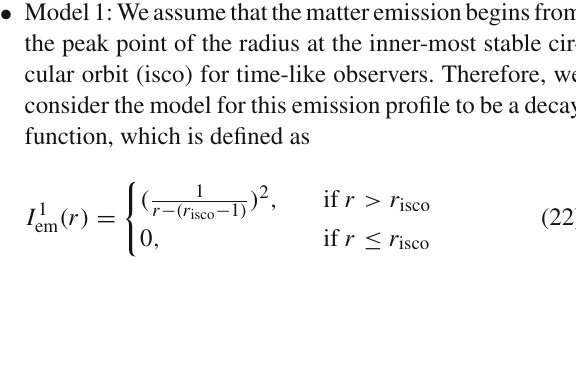
Fig. 5 The profile depicts the first three transfer functions of the BH under different values of parameters. Here, we plot left to right panels with the values of set 1, 2 and 3, respectively and the mass of BH as M = 1